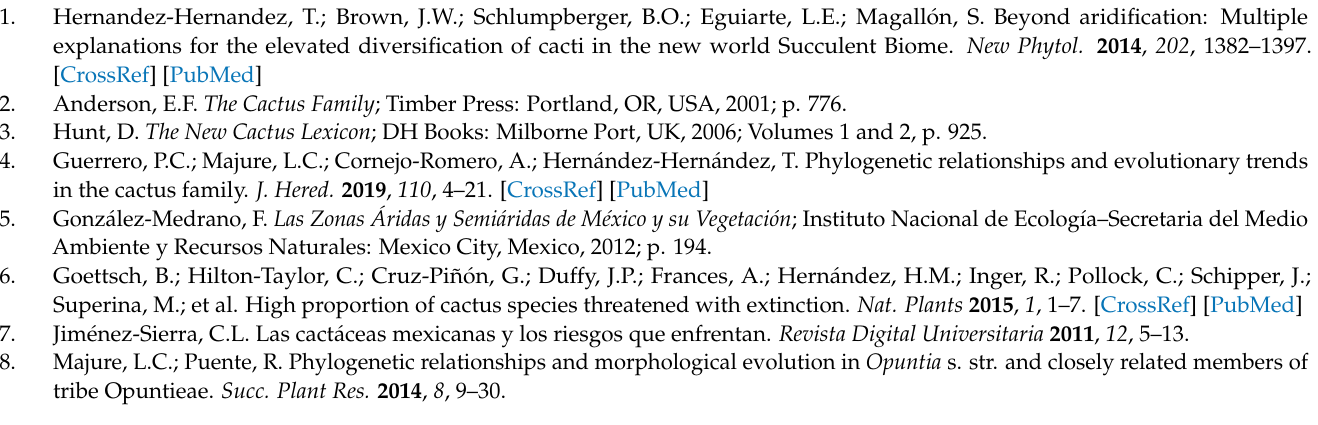
(n: the number of studies). Table S1: Checklist of the 29 Opuntia species with their associated insect flower-visiting species. This database was extracted from the 29 retrieved articles published from 1911 to 2020 worldwide. The references cited herein can be found in the References list in the main manuscript. Note that insect species are listed according to the Order and Family they belong to. Table S2: List of Opuntia and insect species that constitute part of the generalist core in both the global and Mexican